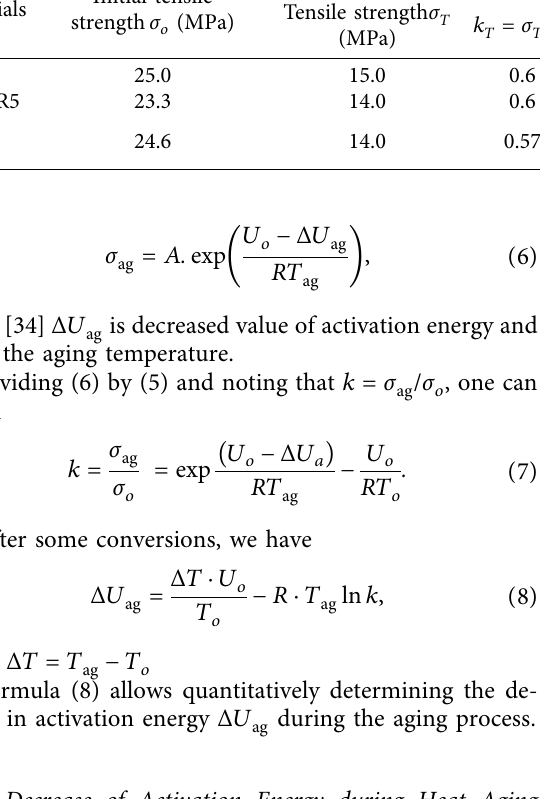
Table 4: Tensile strengths and aging coefficients of NR and NR/CR blends determined at different aging conditions. After heat aging After mechanical Materials